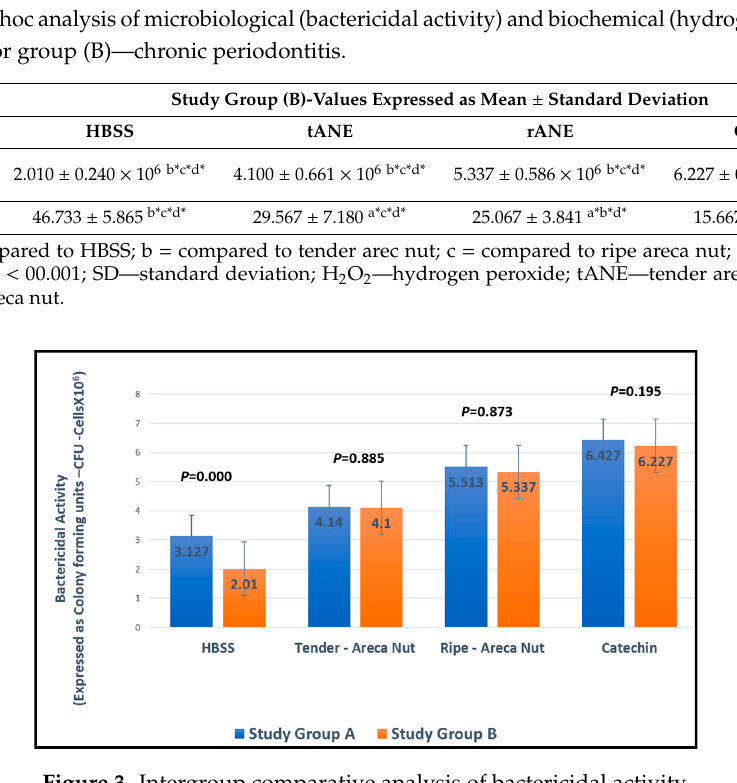
Figure 3. Intergroup comparative analysis of bactericidal activity.